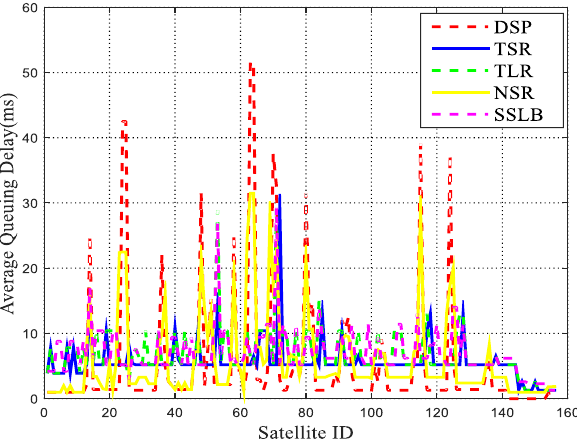
Figure 8. Average queuing delay at each